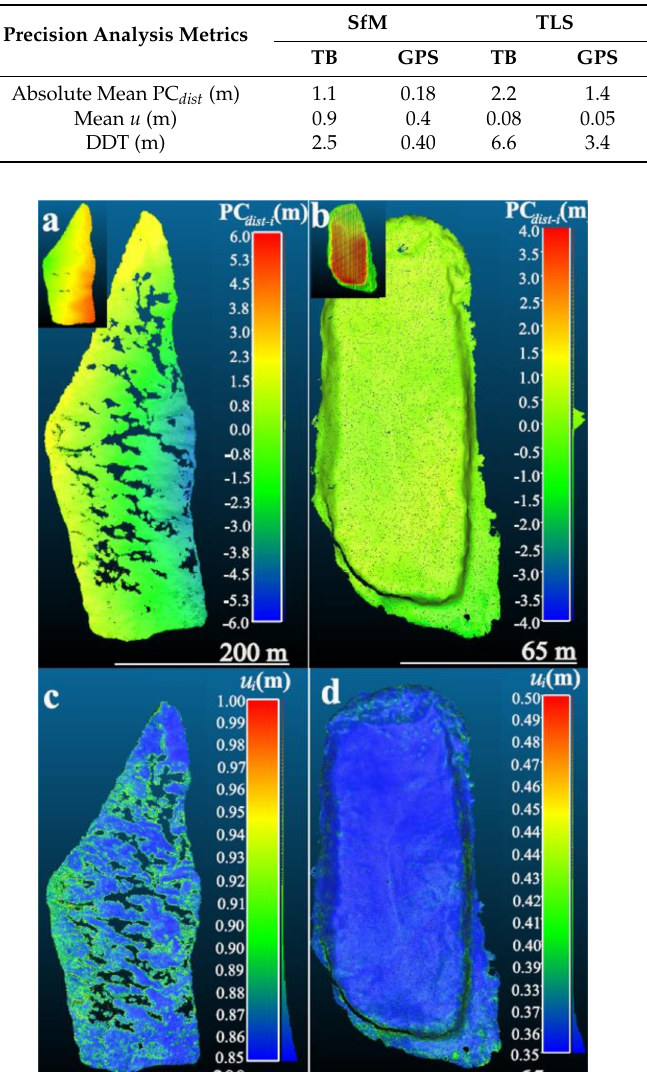
Table 4. Precision assessment of the aerial photography with structure-from-motion photogrammetry processing (SfM) and terrestrial laser scanning (TLS) surveys for i1 and i2 by survey scenario. Each scenario is determined by the combination of the surveying technique and GPS type used. TB = tracking beacon, GPS = dual-frequency GPS receiver, PC dist = distance between point clouds, u = uncertainty, DDT = deterioration detection threshold.